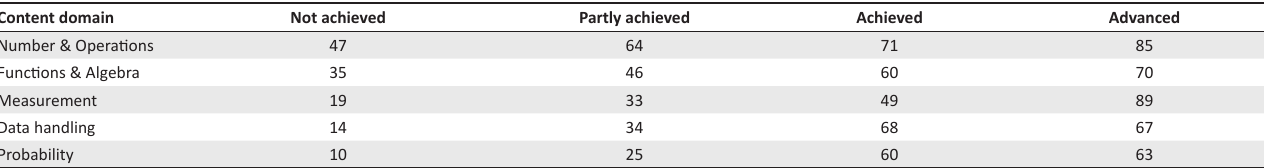
TABLE 5-A1: Mean score ( % ) by content domain and performance level.